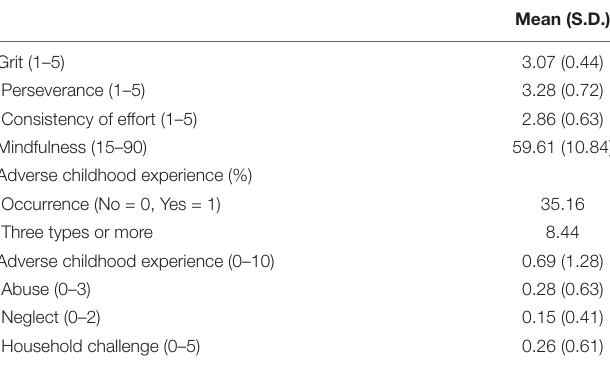
TABLE 2 | Descriptive statistics of socioeconomic